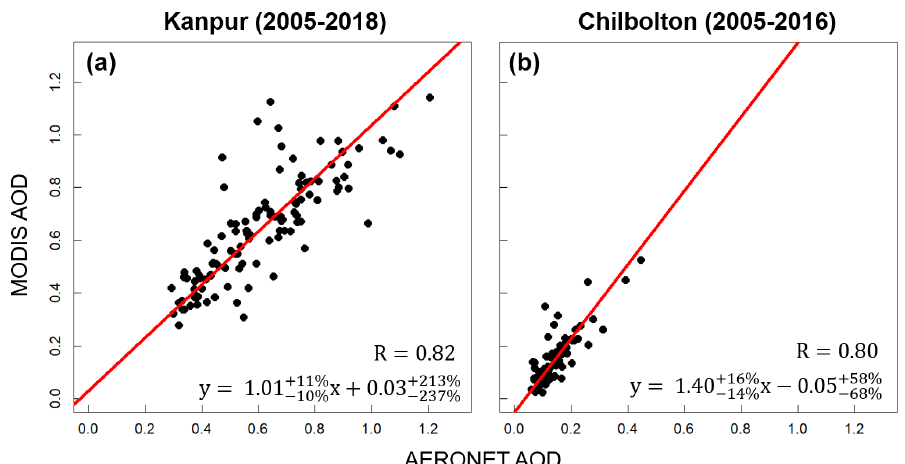
Figure 6. Validation of MODIS AOD with AERONET AOD in Kanpur and Chilbolton. Points are monthly means of MODIS and AERONET AOD for Kanpur (a) and Chilbolton (b) . The red line is the SMA regression. Values inset are Pearson’s correlation coefficients and regression statistics. Relative errors on the slopes and intercepts are the 95% CI.